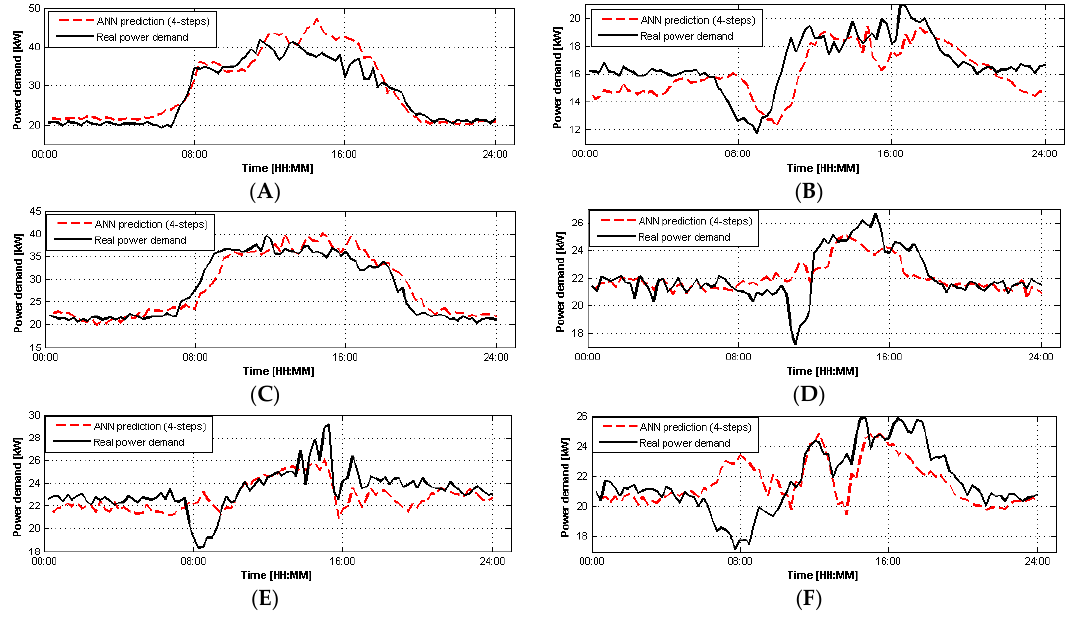
Figure 10. Prediction results for tests ( A – F ) using model III. Table 18. Battery of tests performed to compare the naive autoregressive baseline (NAB) model with the neural networks models.